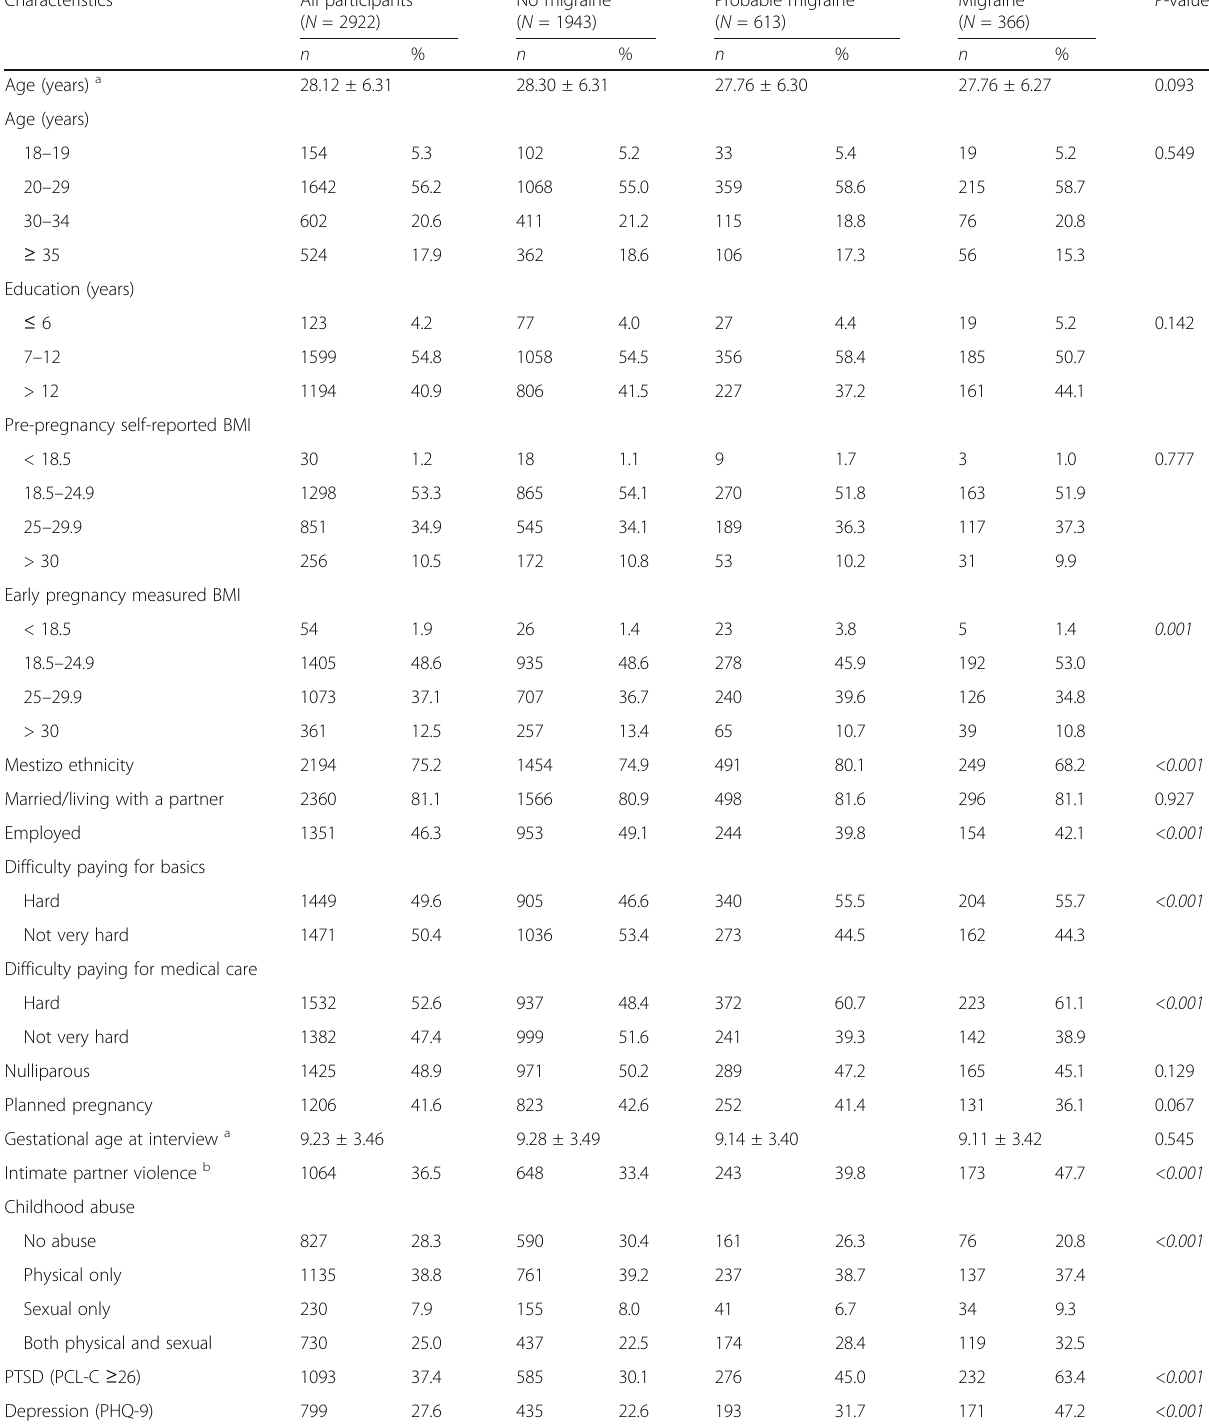
Table 1 Socio-demographic and reproductive characteristics of the study population according to types of migraine in Lima, Peru ( N = 2922)